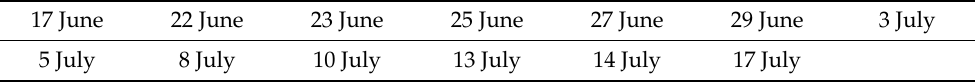
Table 2. UAVSAR flight dates simultaneously with soil moisture measurement over